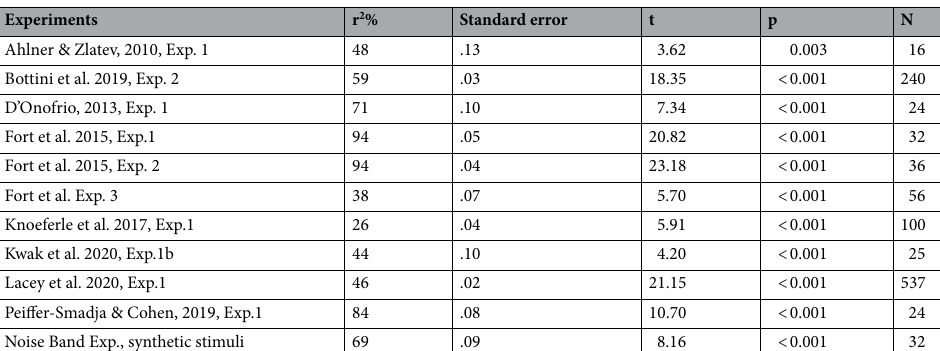
Figure 2. Model round score predictions (Model, y axis) as a function of Experimental round score data (Data, x axis, on the same scale as in the original studies, see Table 2 for more details) for the 10 experiments. For each speech stimulus (displayed by empty circles) in each experiment, the round score prediction in the model is obtained for the boundary b value providing the best fit for the corresponding experiment (cf. "Methods"). Linear regression lines and corresponding explained variance r 2 between experimental and predicted round scores are added to each display.